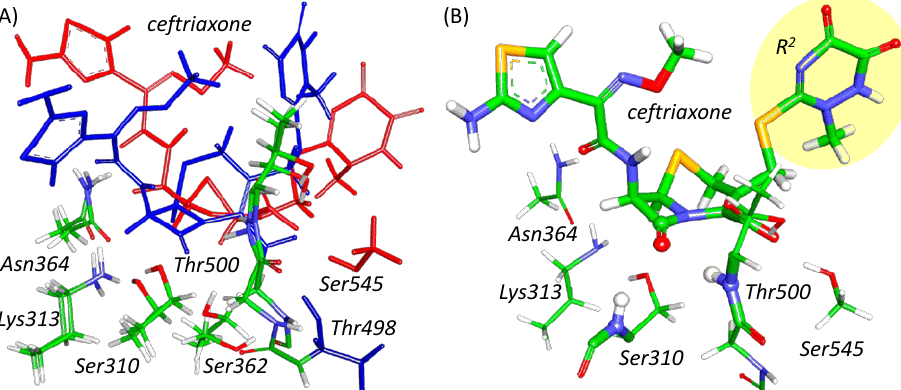
Figure 1. ( A ) Superposition of active site fragments of PBP2 FA19 (blue) and PBP2 H041 (red) with bound ceftriaxone. Alignment is performed over nitrogen and carbon atoms of main chains of Ser310, Lys313 and Thr500. ( B ) The QM part of PBP2 H041 at the ES configuration; the leaving group of ceftriaxone (R 2 ) is highlighted by a yellow ellipse. The carbonyl group of the β -lactam ring and NH fragments of Thr500 and Ser310 residues forming the oxyanion hole are represented as balls and thick sticks. Ceftriaxone and other amino acid residues are depicted with thick and thin sticks, respectively. Here and in the following figures, carbon is green, oxygen is red, nitrogen is blue, hydrogen is white, and sulfur is yellow.